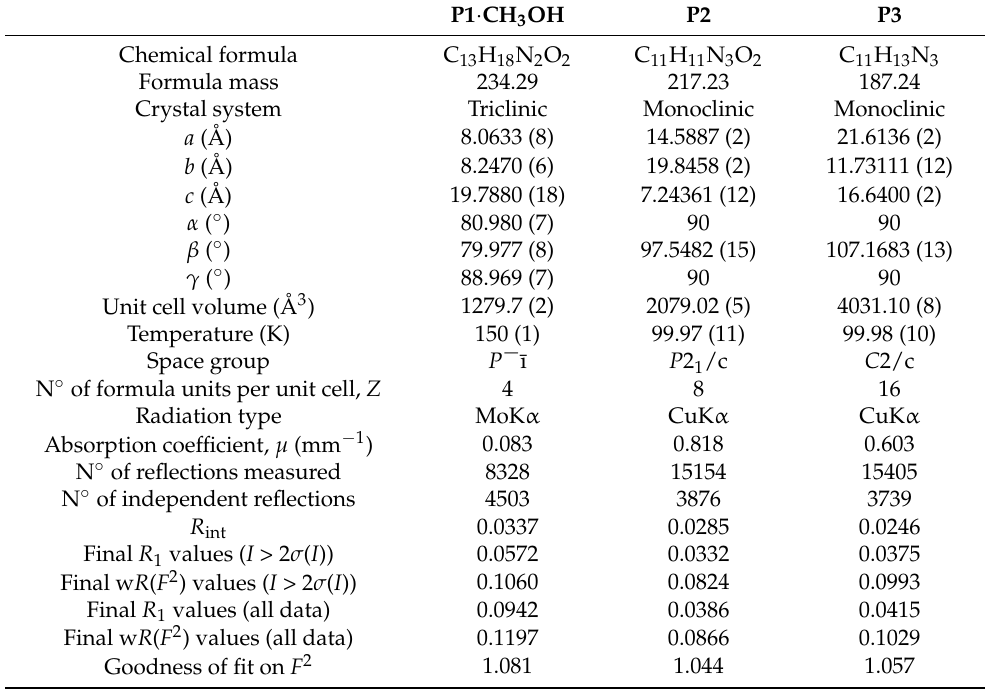
Table 1. Crystal data resolution and refinement